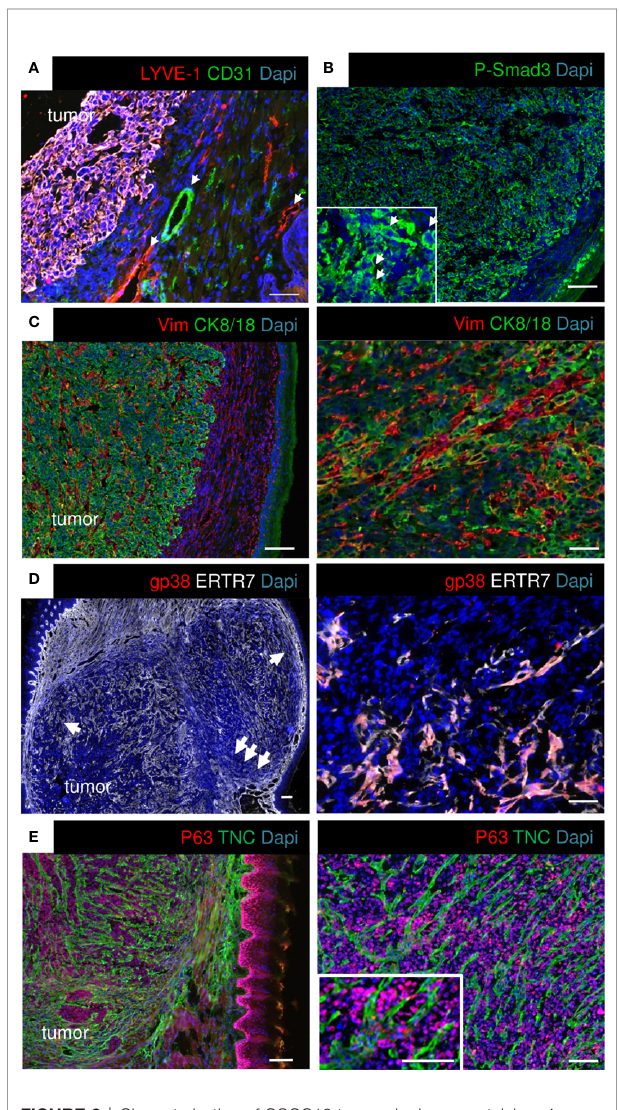
FIGURE 2 | Characterization of OSCC13 tumors by immunostaining. 4 weeks syngeneic tongue tumors derived from 1 × 10 6 engrafted OSCC13 cells were stained for the indicated molecules. Representative images are shown (N = 3). Scale bar, 100 µm. Arrows point at LYVE+ lymphatic and CD31+ blood vessels in the surroundings of the tumor mass (A), at P-Smad3+ cells (higher magni fi cation inlet in B ), and at ERTR7+ cells invading the tumor mass from the surrounding tissue (D) . (C – E) , scale bar, 500 m m (left). Right panels, higher magni fi cation, scale bar, 100 m m (C, E) , 50 m m (D)